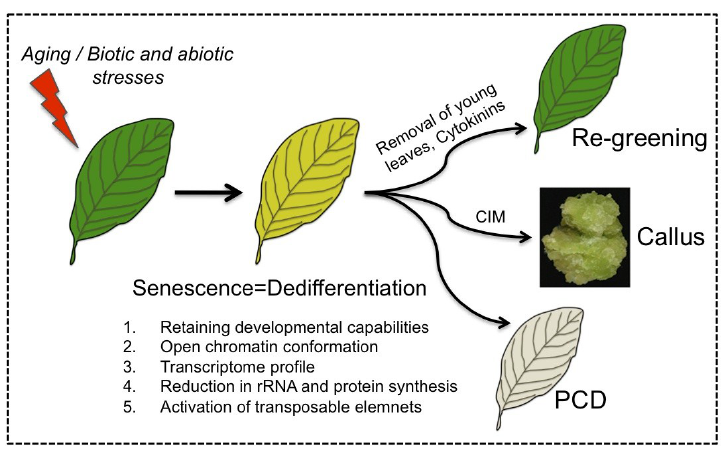
Figure 2. Senescing cells feature dedifferentiation. Leaf senescence is established developmentally as the leaf mature and aged or by biotic and abiotic stresses. Similarly to dedifferentiating cells, senescing cells retain developmental potentialities, acquire open chromatin conformation, and display activation of TEs. Senescing cells can be triggered by various stimuli including removal of young leaves or application of cytokinins to re-green and regain photosynthetic activity, re-enter the cell cycle and form callus upon incubation on callus inducing medium (CIM) [54] or die in an orderly manner (PCD). Activation of TEs in the course of cell dedifferentiation indicates that dedifferentiation events